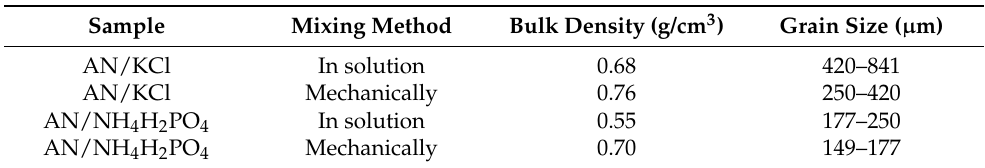
Table 8. Differences in bulk densities and grain sizes depending on the method of mixture preparation. Reprinted with the permission of Springer Nature from